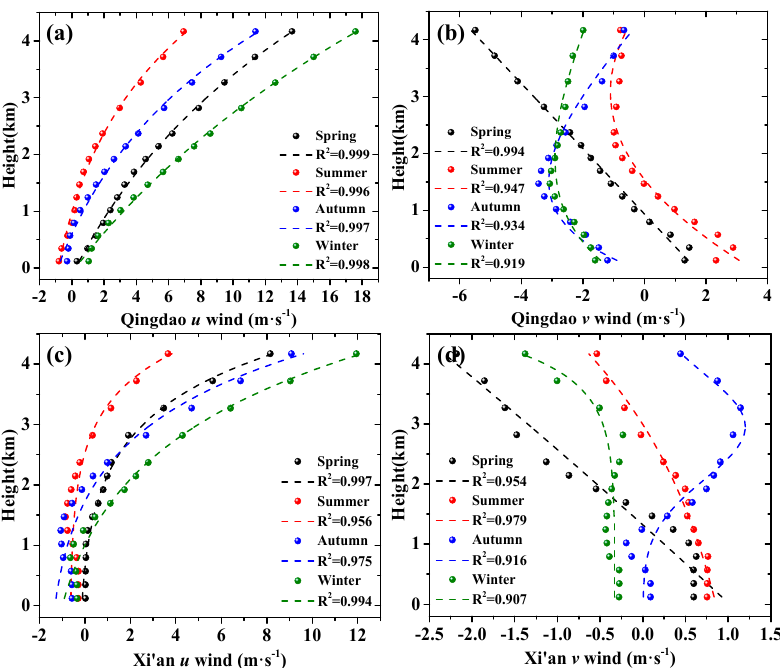
Figure 4. Exponential fitting curves of wind speed varying with height: ( a ) the 𝑢 wind in Qingdao; ( b ) the 𝑣 wind in Qingdao; ( c ) the 𝑢 wind in Xian; ( d ) the 𝑣 wind in Xian.